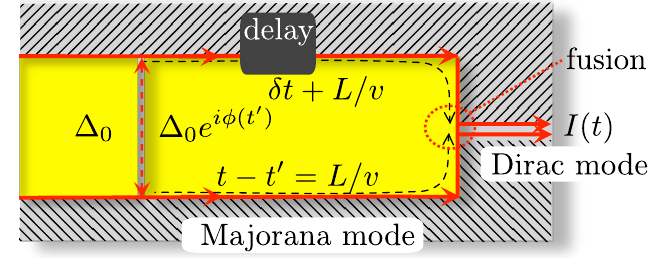
Figure 3: Geometry described by the scattering matrix